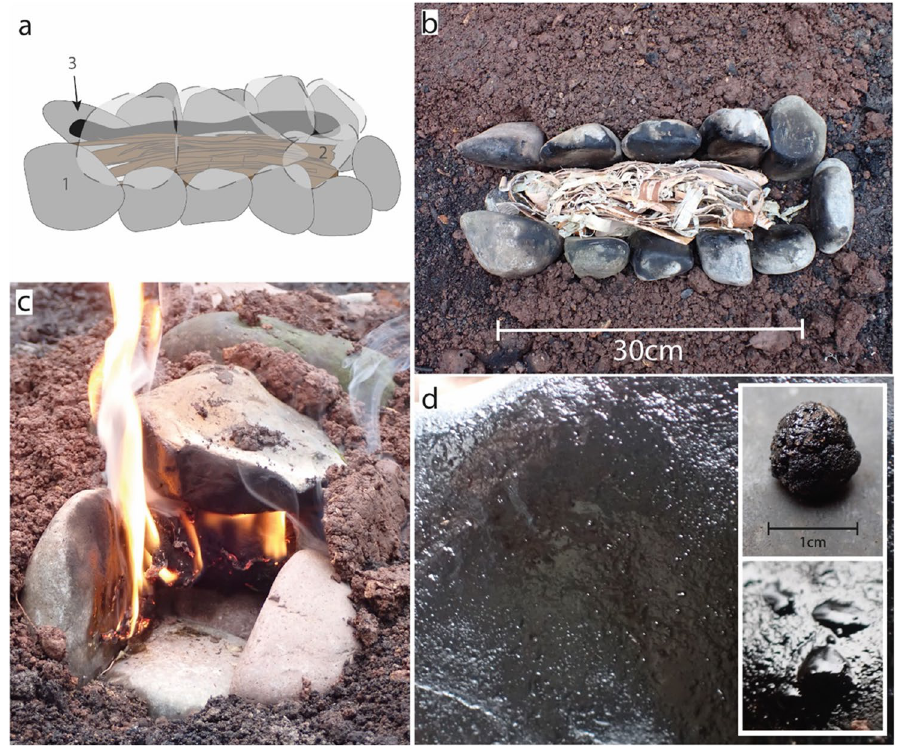
Figure 2. Experimental birch tar production with the cobble-groove condensation method. ( a ) Experimental set up of cobble-groove (1) showing the wall cobbles in dark grey, the ceiling cobbles with a dashed outline; the three bottom cobbles are hidden underneath the bark strips (2). The birch tar (3) is condensed onto the wall and ceiling cobbles. ( b ) Photo taken during the fourth experiment with clearly visible dark spots on the cobbles. ( c ) Frontal view of the upper opening of the structure during the burning procedure showing the bottom cobbles and the sediment chunks filling the gaps between the cobbles. ( d ) Close-up photo of condensed tar on a cobble, photo of a 0.27 g-piece of tar produced in 22 min, and a close-up photo of tar